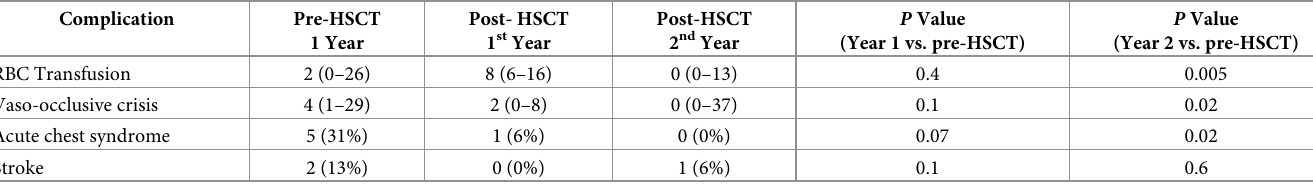
Table 2. Sickle cell disease-related complications after hematopoietic stem cell transplantation (n = 16).